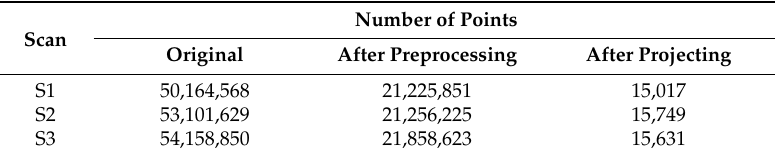
Table 2. Initial distance between adjacent scan positions and the corresponding reference.